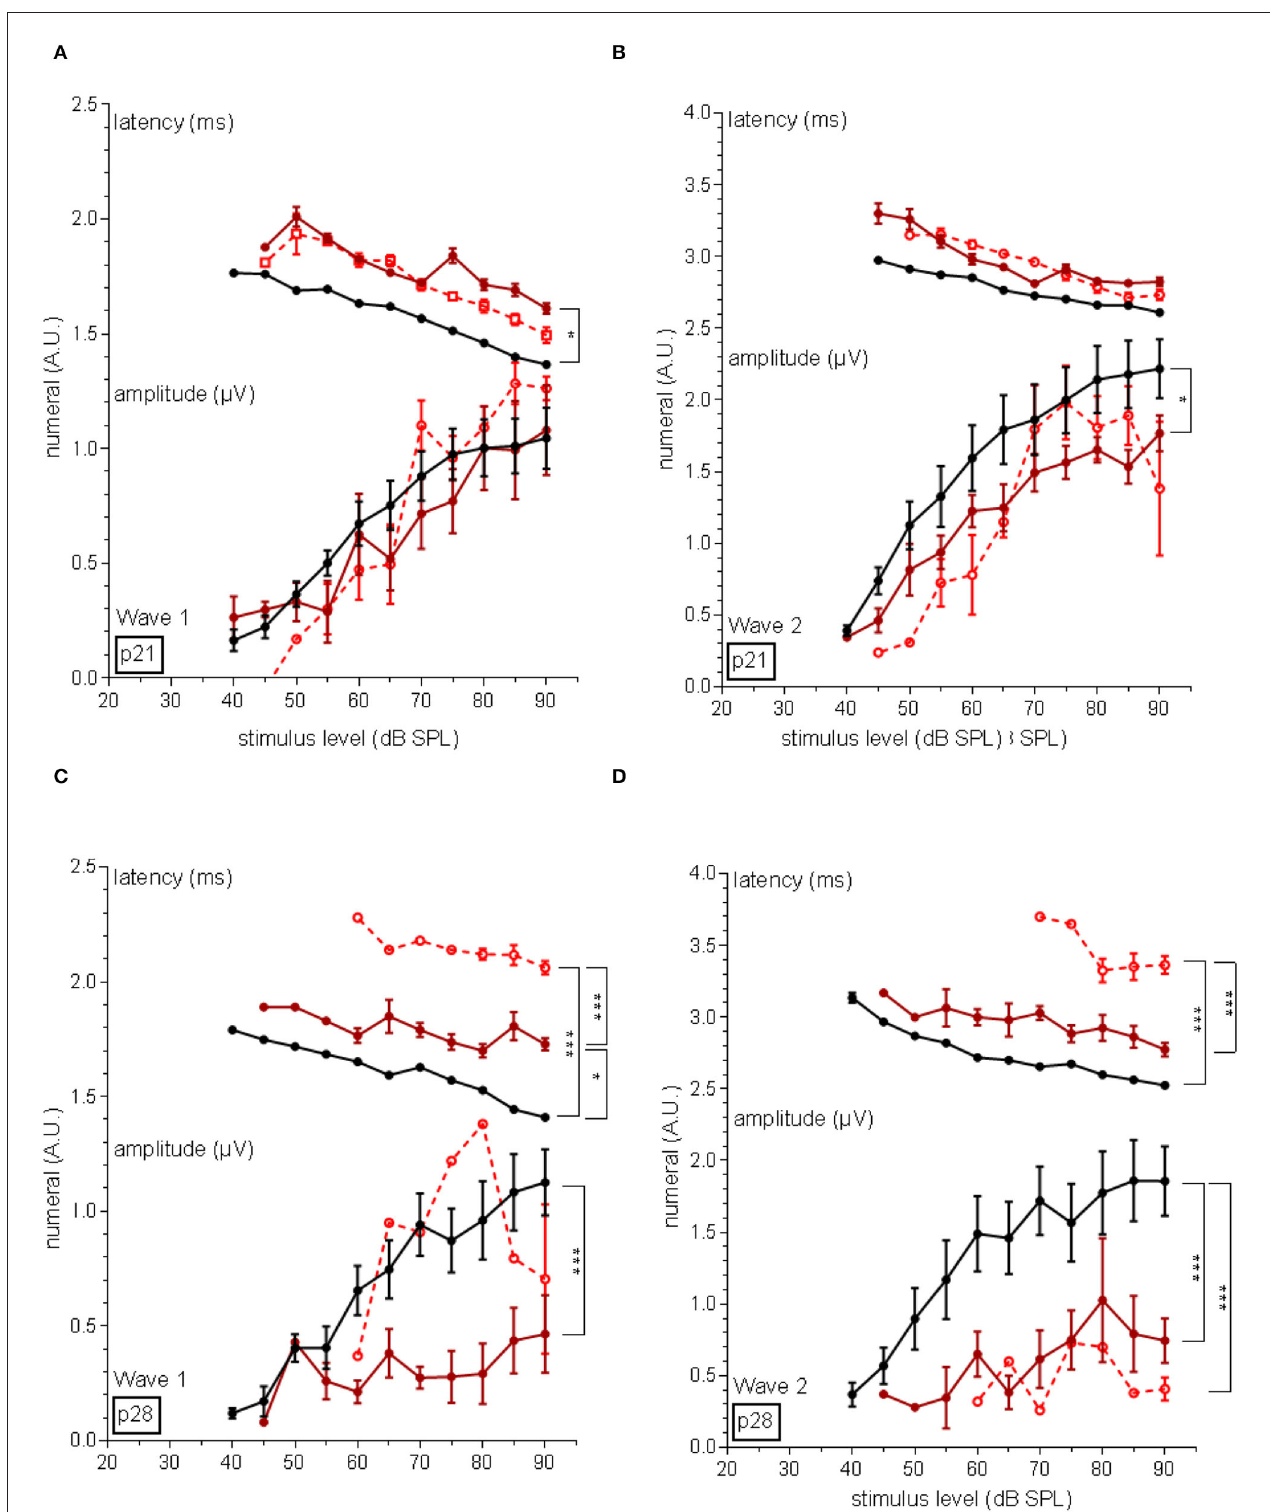
FIGURE 5 | Amplitudes and latency of wave I and II of the auditory nerve. (A) At the age of p21, wave I of untreated PMN mice showed a latency shift compared to the wildtype animals ( p < 0.05). Amplitudes of PMN mice did not differ. (B) 1 week later, untreated PMN mice still implicated a latency shift ( p < 0.05) but